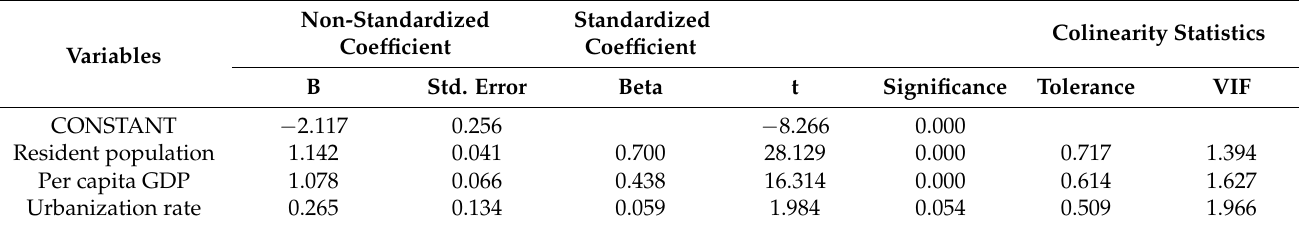
Table 9. Model test results of Hangzhou metropolitan